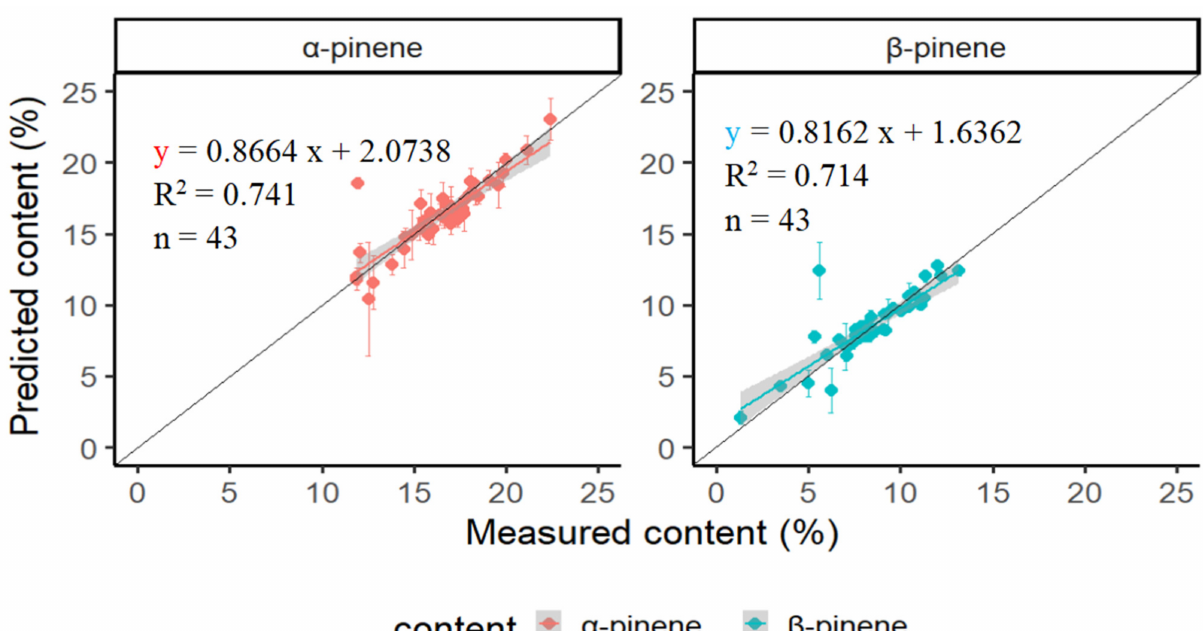
Figure 3. The α - and β -pinene content for the separate validation samples predicted by the PLS model and their relationship between measured and predicted.